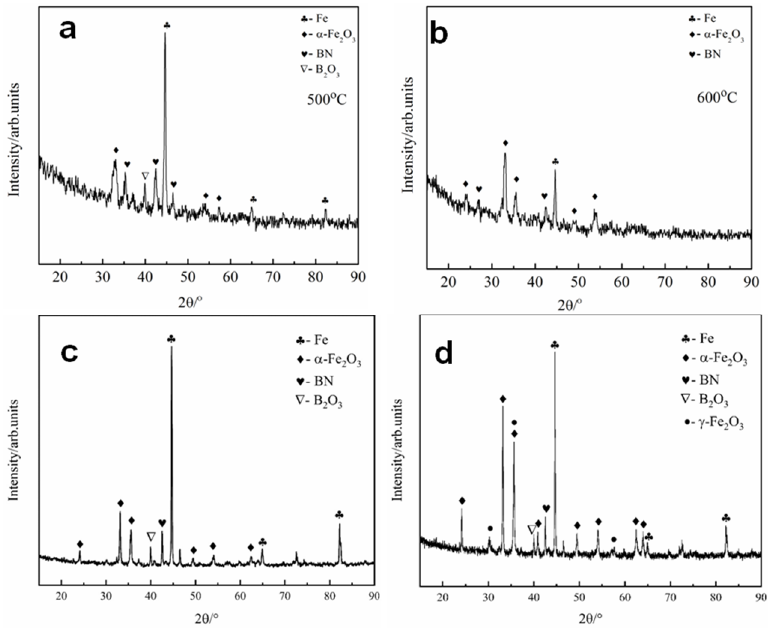
Figure 11. XRD of the worn surface of h-BN coatings under different temperatures:( a ) 500 °C, ( b ) 600 °C, ( c ) 700 °C and ( d ) 800 °C.